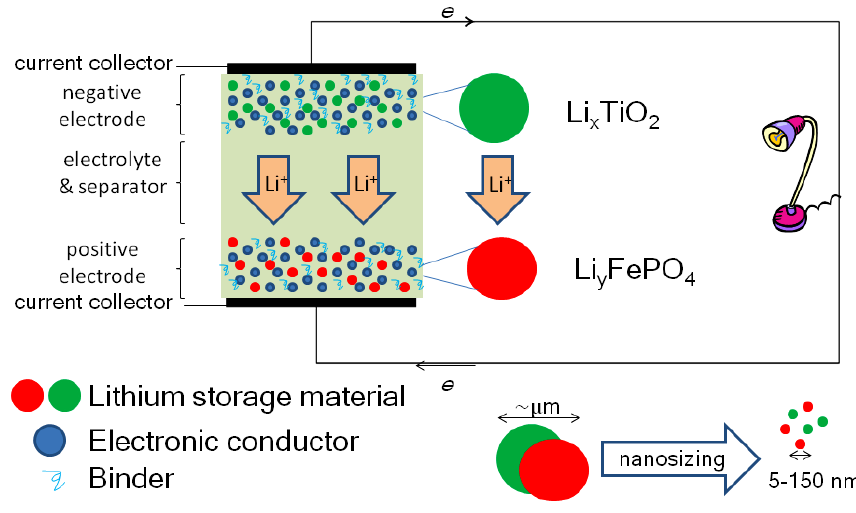
Figure 2. A typical electrochemical (metal ion) battery. During charging, an external potential is applied; metal ions (Li + , Na + , …) migrate from the cathode and intercalate/insert into the anode. During discharge (shown here), the electrode potential (arising from differences in the chemical potential of Li/Na at the anode and the cathode) induces the reverse process with the electrons travelling through the external circuit to produce electrical work. TiO particles have emerged as safe high-rate anodes for 2 electrochemical batteries. What are the effects of nanosizing? What is the dynamics of Na vs . Li insertion, and how to optimize